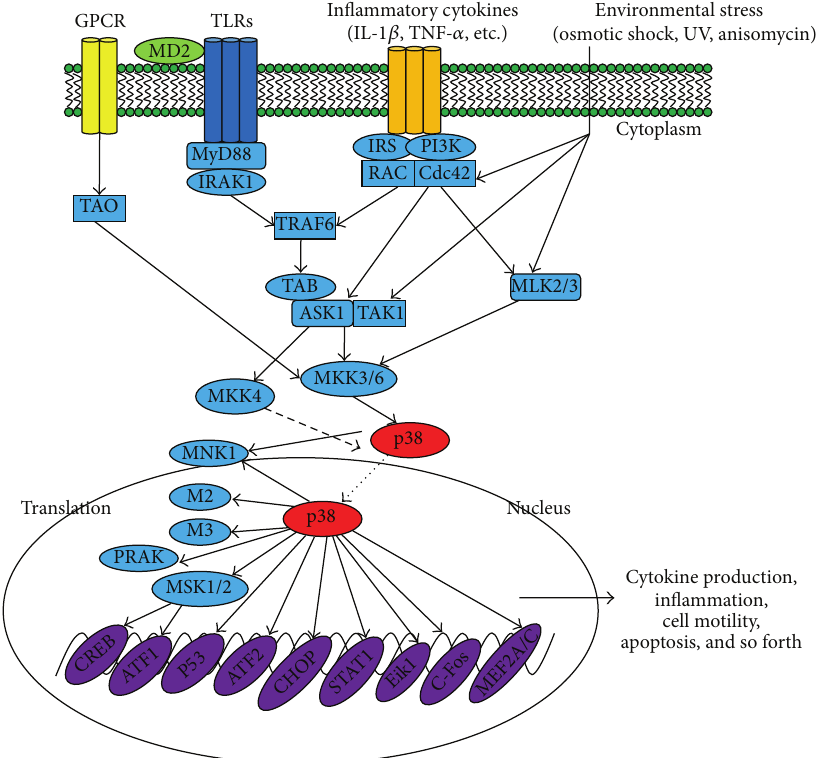
Figure 1: p38-regulated signaling pathways in inflammatory responses. Inflammation-derived cytokines such as TNF- 𝛼 and IL-1, TLR ligands such as LPS, poly(I:C), and peptidoglycan, as a environmental stresses, stimulate the phosphorylation of p38, leading to the activation of transcription factors such as AP-1 family. Subsequent expression of inflammatory genes by these transcription factors mediates various inflammatory responses including cytokine production, migration, and apoptosis of macrophages, monocytes, and neutrophils. able to stimulate p38 kinases, for example, insulin